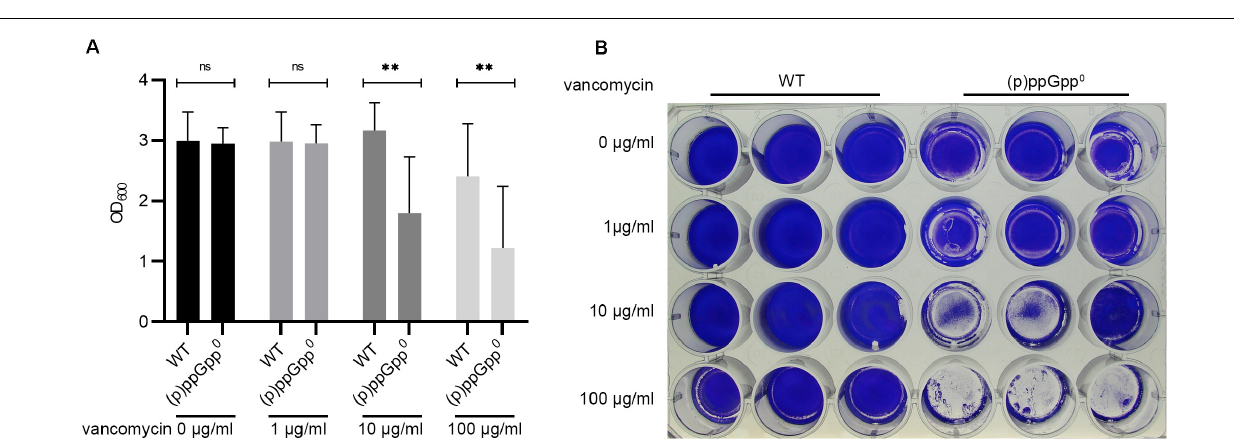
FIGURE 5 | (p)ppGpp contributes to biofilm related antibiotic tolerance. (A) Preformed biofilms (8 h) were exposed to increasing concentrations of vancomycin for 16 h. Three separate experiments were performed with biological triplicates each. Error bars represent the standard deviation, statistical significance based on ordinary one-way ANOVA (ns: not significant, **: P < 0.01). (B) Representative plate stained with crystal